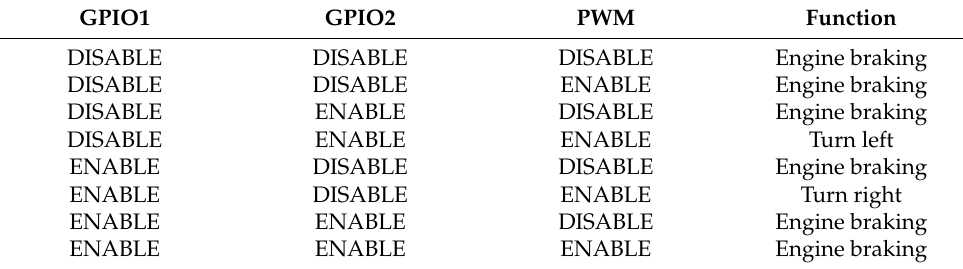
Table 3. Truth table of AND logic gates for motor rotation activation.